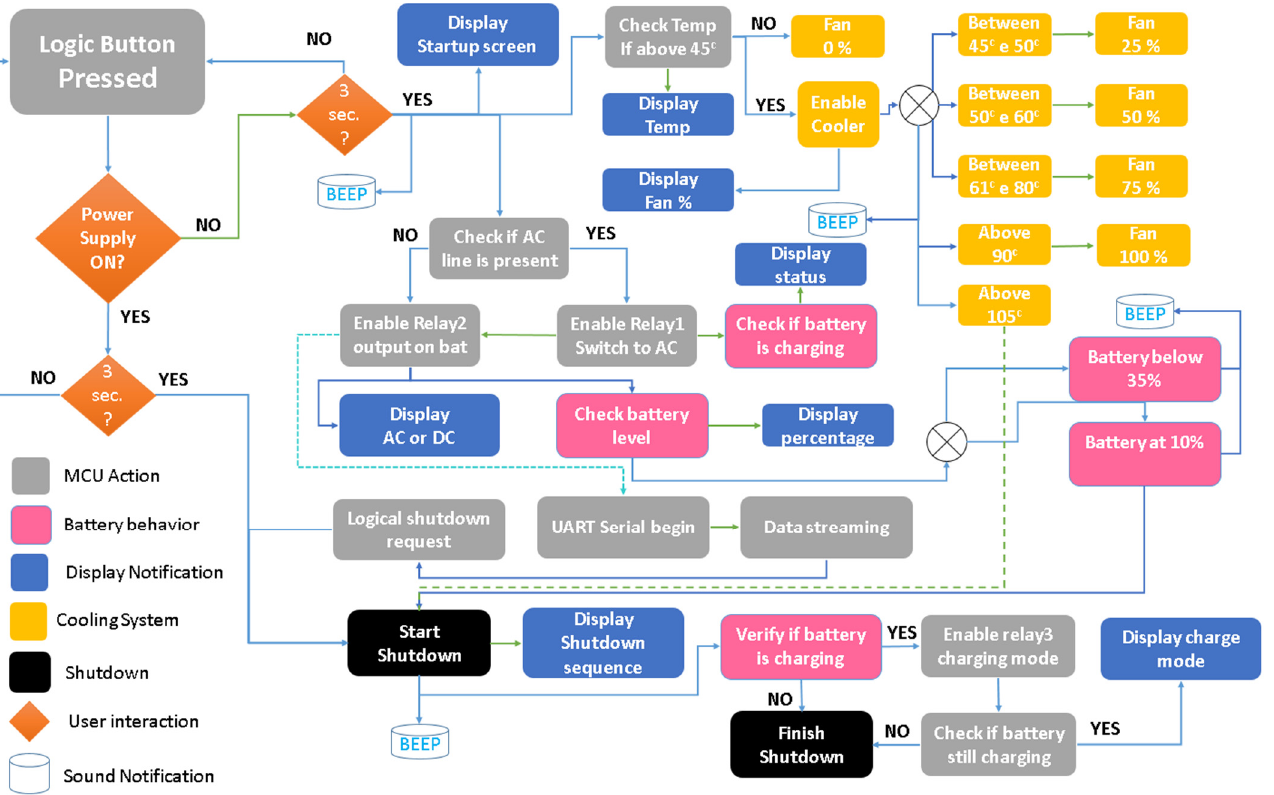
Figure 6. Block diagram of the firmware behavior.